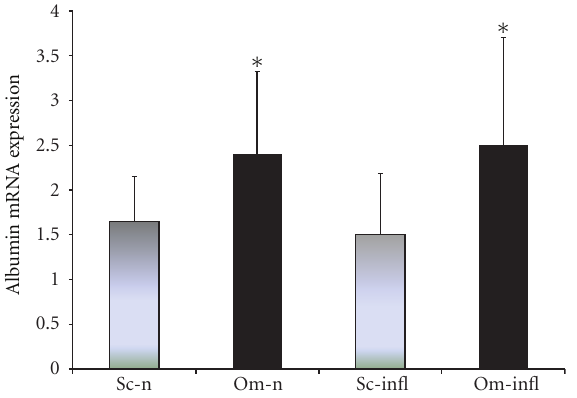
Figure 3: Albumin gene expression in the adipocytes and pre- adipocytes from di ff erent sites of adipose tissue of a single noninflamed subject, as representative of six experiments for all the subjects enrolled, obtained by real-time PCR analysis. The columns show the relative expression of albumin mRNA in Sc (gray bars) and Om (black bars) adipocyte (Sc-AD and Om-AD) and preadipocyte (PreAD) of a single healthy subject, as representative. The values on the y -axis represent arbitrary units derived from the mean expression value for albumin